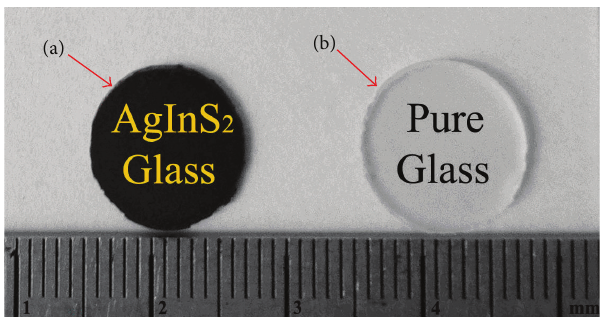
Figure 1: Photograph of as-obtained glass: (a) AgInS 2 nanocrystals glass and (b) pure glass.